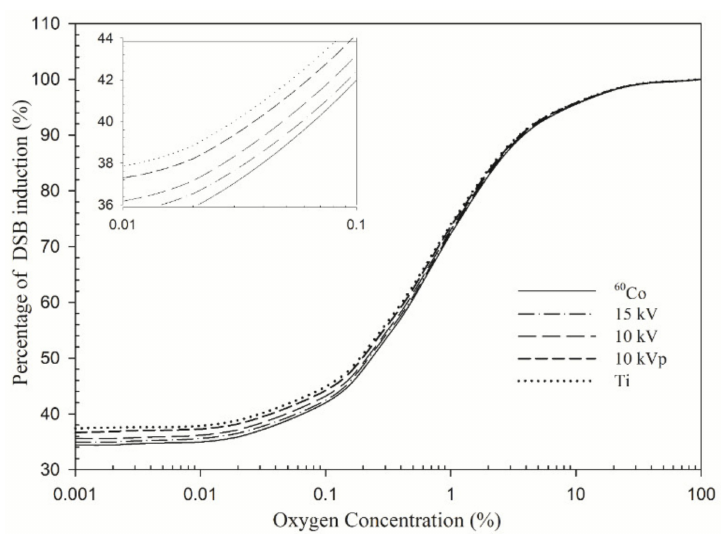
Figure 1. Percentage of double-strand break (DSB) induction as a function of oxygen concentration: the symbol Ti denotes titanium